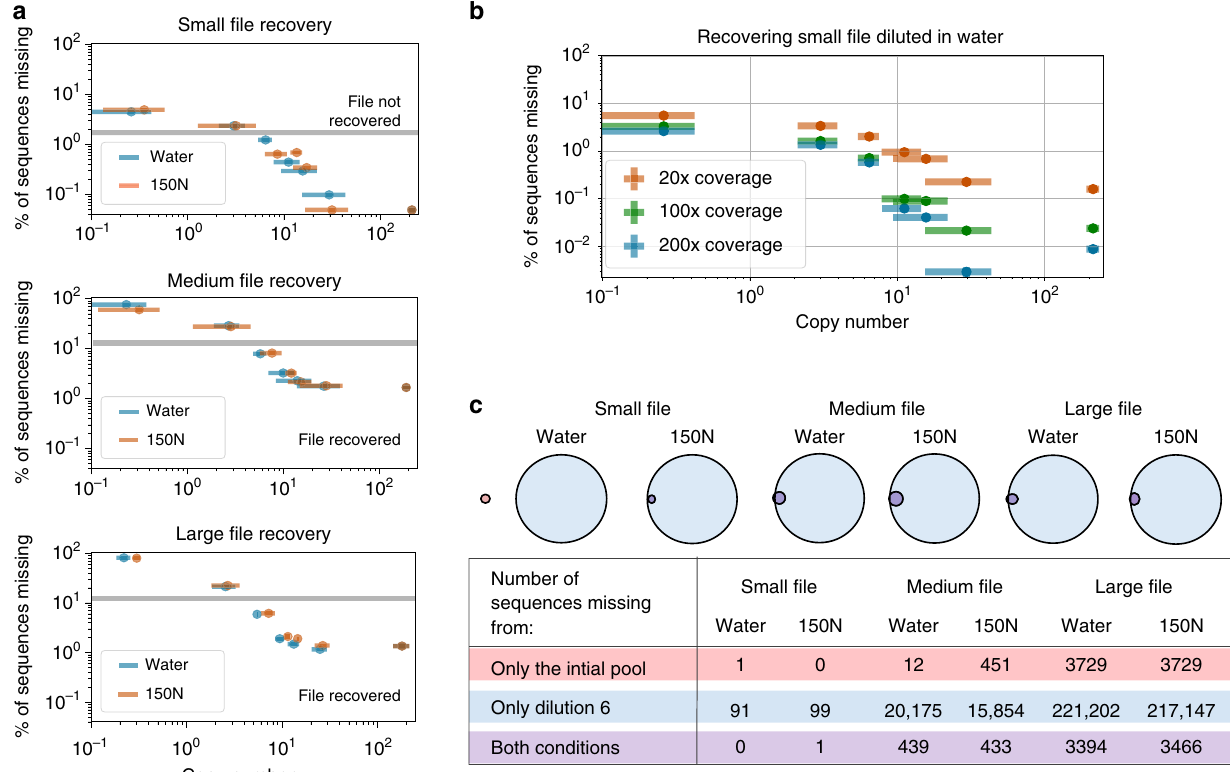
Fig. 3 Examining fi le recovery, sequencing coverage, and sequence loss behavior. a The limit of successful, no bit error decoding is shown with the gray bar in each graph. Data points below the gray bar are samples where the fi le was successfully decoded and recovered with no bit errors. Done post- sequencing, decoding involves clustering sequences, fi nding consensus, then correcting errors 10 . A more detailed view of this data including exact copy number and sequencing coverage is in Supplementary Note 7. b For the small fi le, when each sample diluted in water was sequenced at greater depth, minimal improvement on the proportion of missing sequences occurred. The 100× coverage data were found by sub-sampling the data used to create the 200× coverage data. c Missing sequences are compared between the initial pool prior to any dilutions where the mean copy number was 194 (in red) and the last dilution where the mean copy number was <1 (in blue). Note the different total number of sequences in the small (2042), medium (26,404), and large (271,447) fi les. The fact that some sequences are missing only from the initial pool but “ reappear ” in the fi nal dilution suggests that the lost sequences are a result of stochastic variation that occurs during sub-sampling for fi le recovery, rather than irretrievably lost due to some property of the sequence. This pattern of sequences reappearing in subsequent dilutions is shown for every dilution step in Supplementary Note 6. Note that for a , b , x -axis and y -axis error bars represent 95% con fi dence intervals; x -axis errors are taken from triplicate qPCR data (see Methods), and y -axis errors are the result of 100 simulations of the original sequencing data sub-sampled to 20× sequencing coverage (see